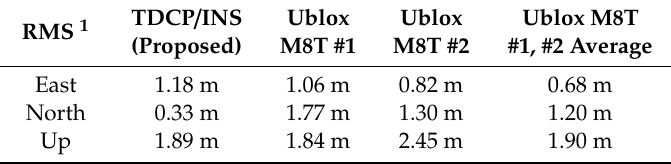
Table 3. RMS errors of the proposed method with other filtered solutions (1 h).